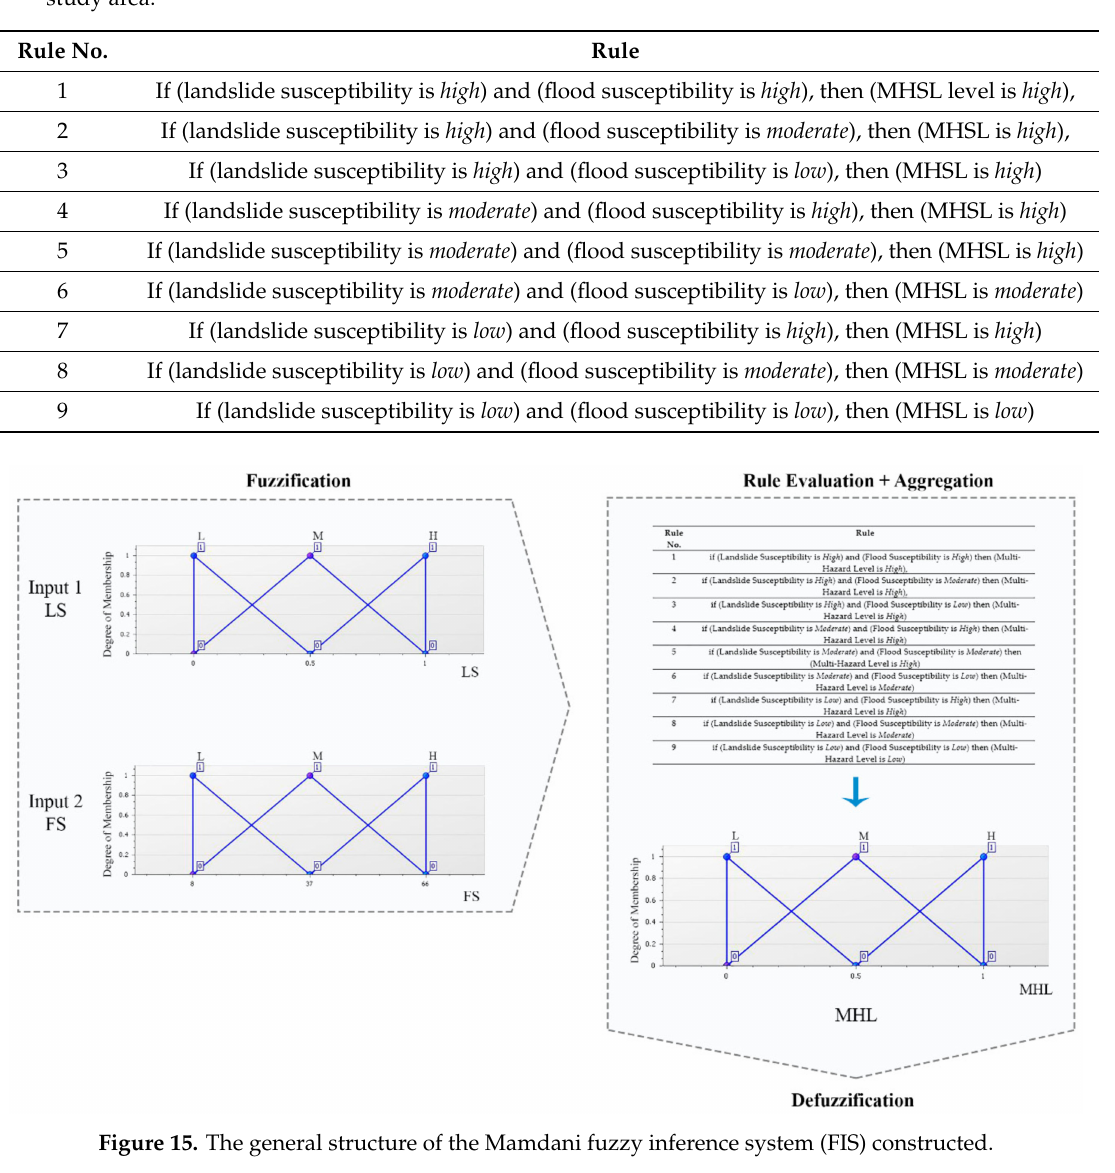
Figure 14. The membership functions of each input. The vertical axes in both graphs represent the degree of membership, while the horizontal axes reflect the susceptibility level range for landslide ( left ) and flood ( right ). Table 6. If–then fuzzy rules used for the multi-hazard susceptibility level (MHSL) assessment in the study area.